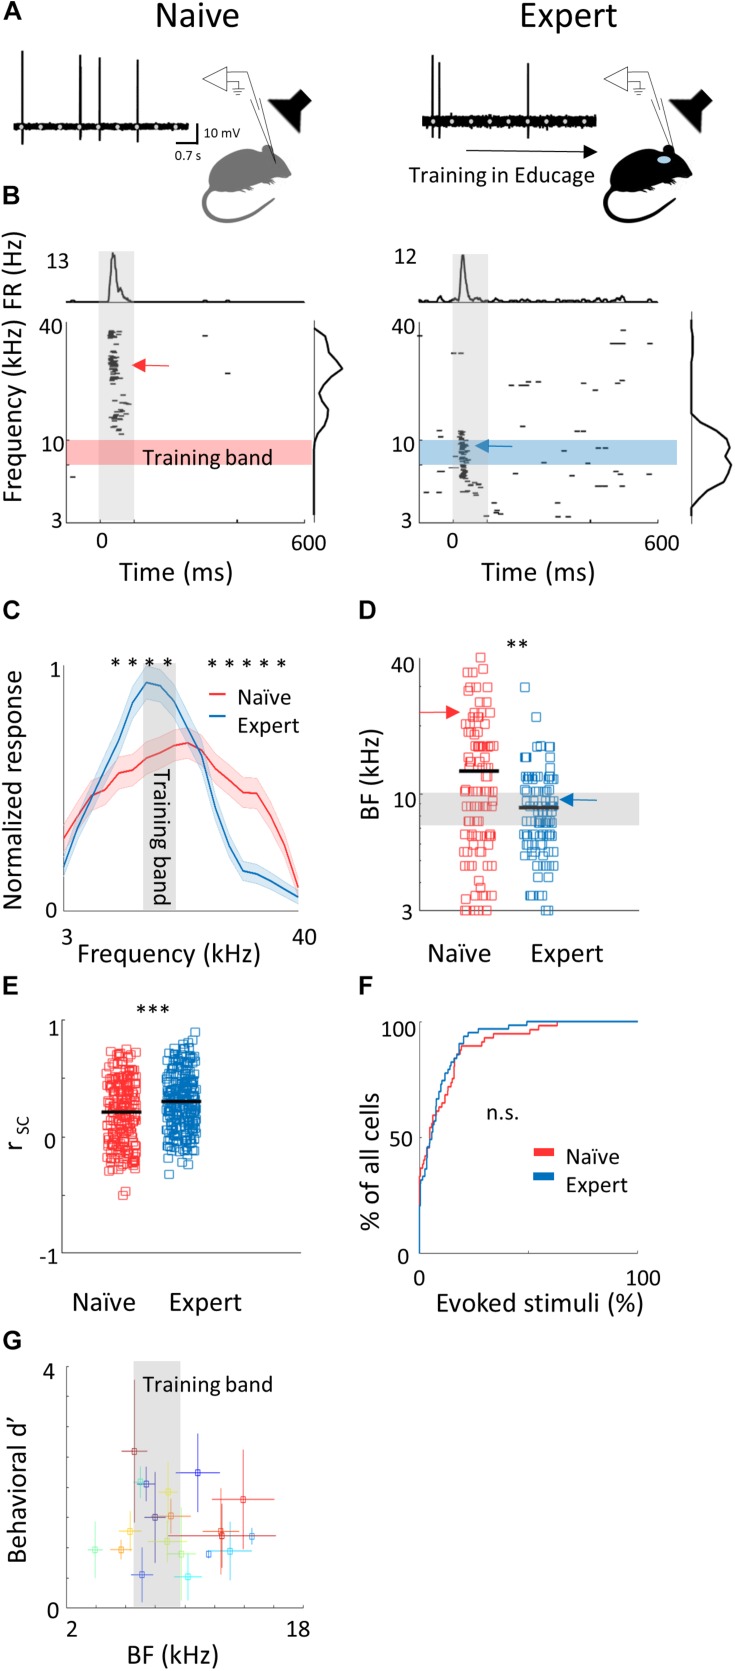
Learning induces over representation of the learned stimuli. (A) Schematic representation of the experimental setup and a sample of the loose patch recording showing a representative cell from naïve (left) and expert (right) mice (gray markers indicate tone stimuli). (B) Raster plots and peri-stimulus time histograms (PSTH) in response to pure tones of the cells shown. Gray bars indicate the time of stimulus presentation (100 ms). Color bars and arrows indicate the training frequency band (7.1–10 kHz) and BF, respectively. (C) Population average of normalized response tuning curves of 105 neurons from naïve mice (red) and 107 neurons from expert mice (blue; mean ± s.e.m.). Gray area indicates the training frequency band. Asterisks correspond to frequencies with significant response difference (Mann–Whitney U test: ∗p < 0.05). (D) Best frequency (BF) of individual neurons from naïve (mice (red markers) and expert mice (blue markers; Mann–Whitney U test: ∗∗p < 0.01). Arrows indicate the neurons shown in (B). (E) Pairwise signal correlations (rsc) values between all neighboring neuronal pairs in naïve (red) and expert (blue) mice. Neurons in expert mice have higher rsc (Mann–Whitney U test: ∗∗∗p < 0.001). (F) Cumulative distribution of response selectivity in naïve (red) and expert (blue) mice. Response selectivity was determined as the % of all frequency–intensity combinations that evoked a significant response. Distributions are not significantly different (Kolmogorov–Smirnov test; p = 0.69). (G) Mean BF of the neurons recorded in each mouse and its behavioral d′ (during the 14% octave discrimination) shows no clear pattern of change with respect to mouse performance (mean ± std across trials; r2 = -0.05, p = 0.7).)